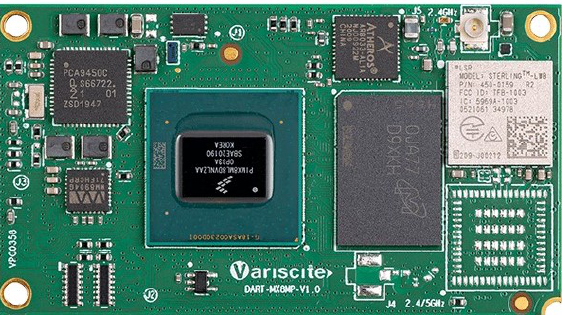
Figure 1. iMX 8M Plus System on Module. Image from https://www.variscite.com/ (accessed on 2 September 2021).